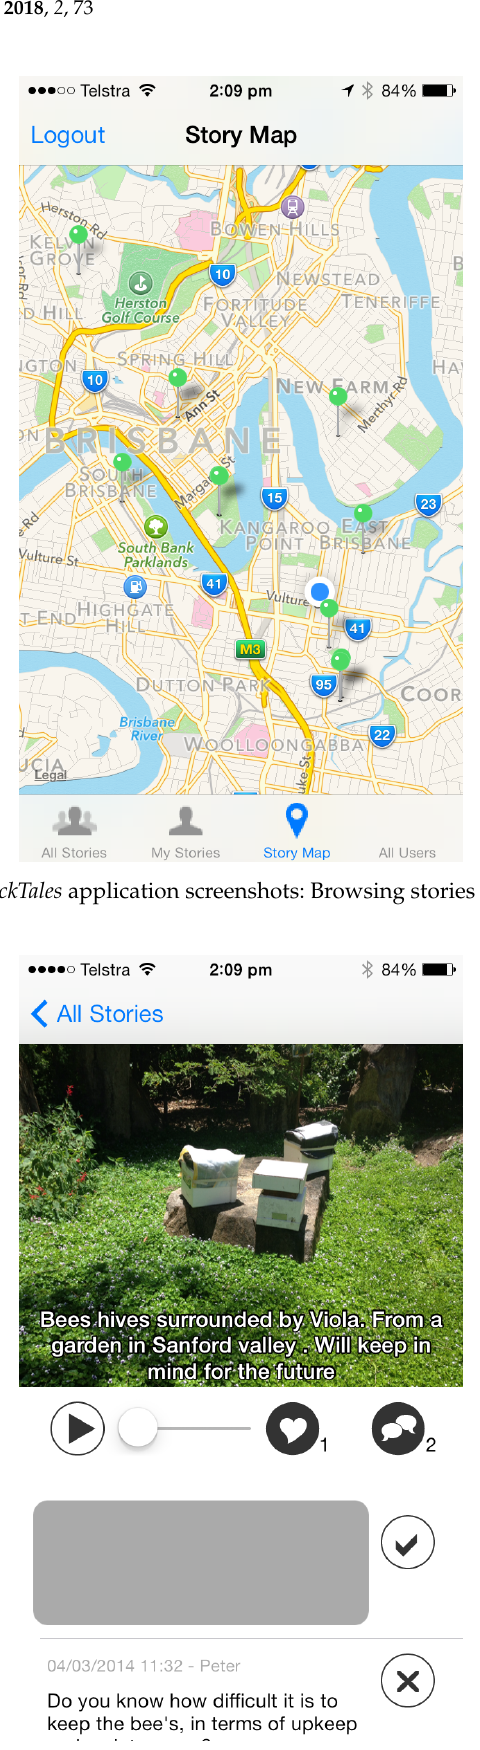
Figure 3. QuickTales application screen-shots: Viewing